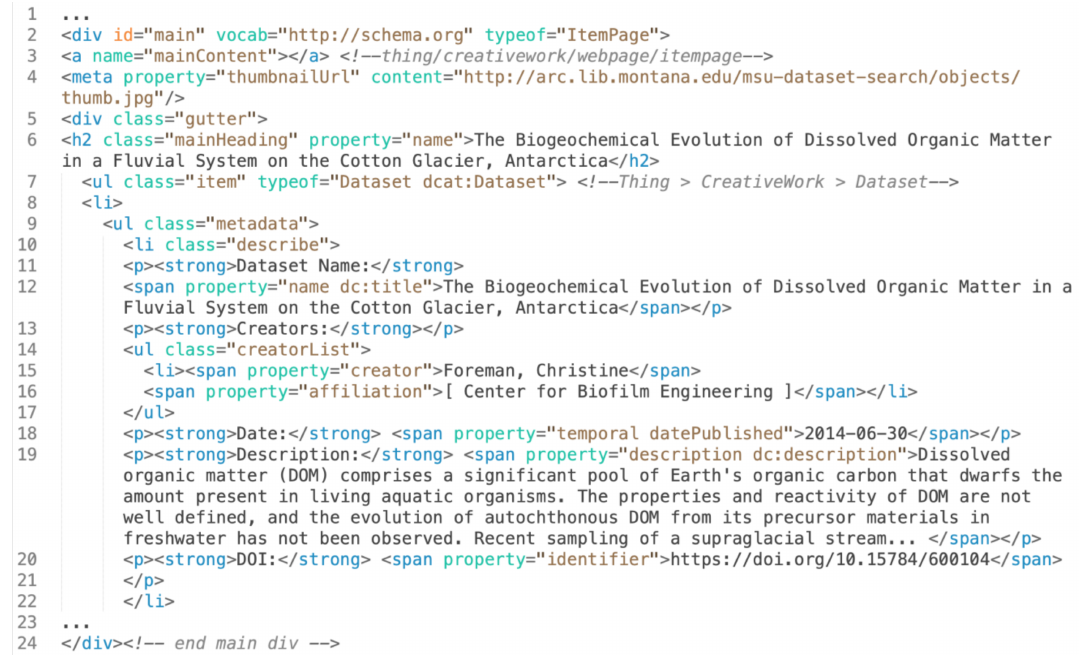
Figure 7. The RDFa of data item